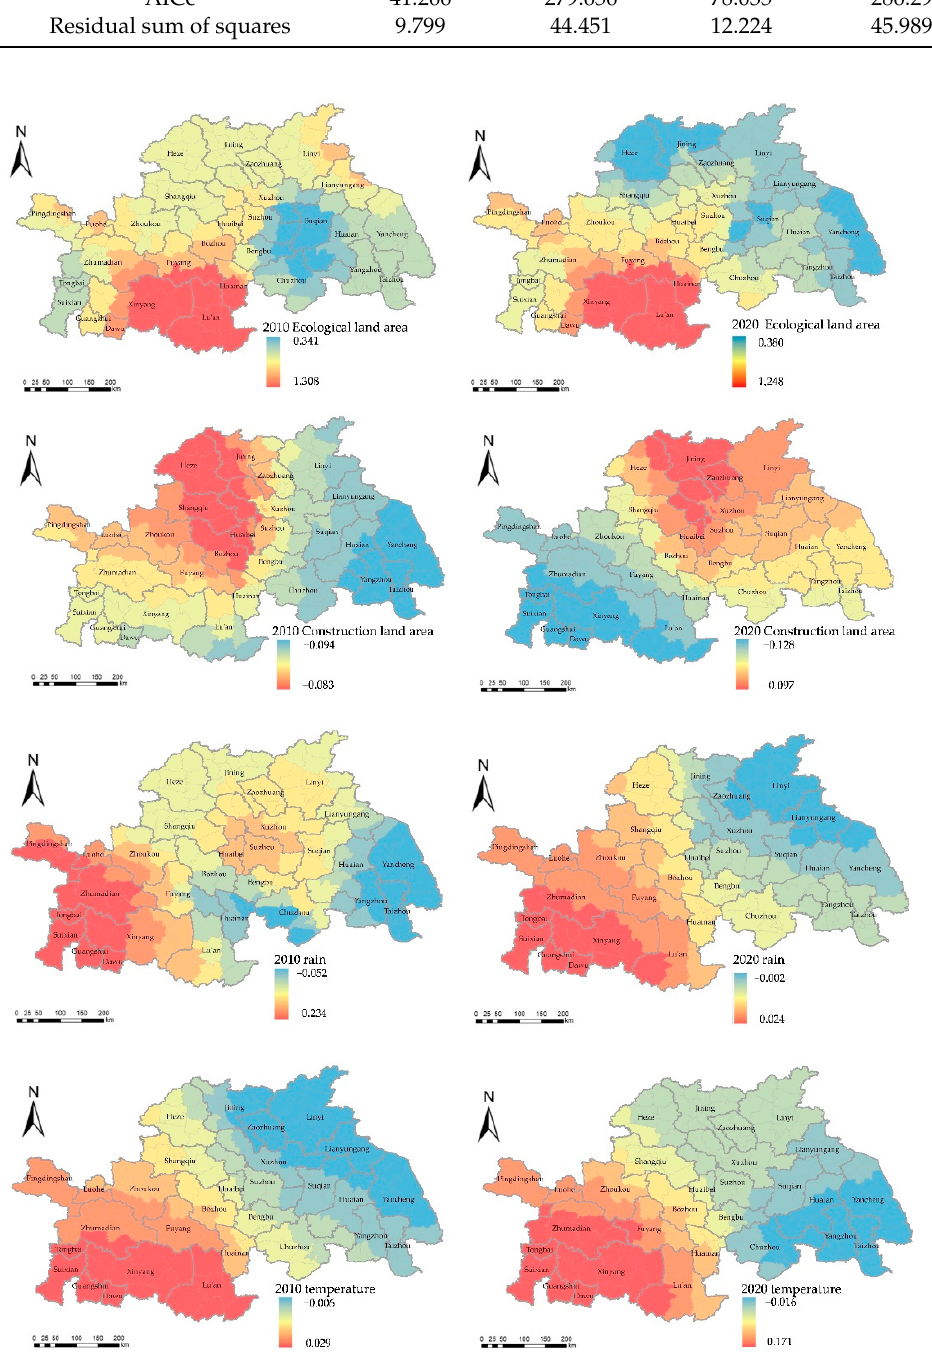
Figure 8. Distribution of regression coefficients of factors that affect the Huai River Basin SDI